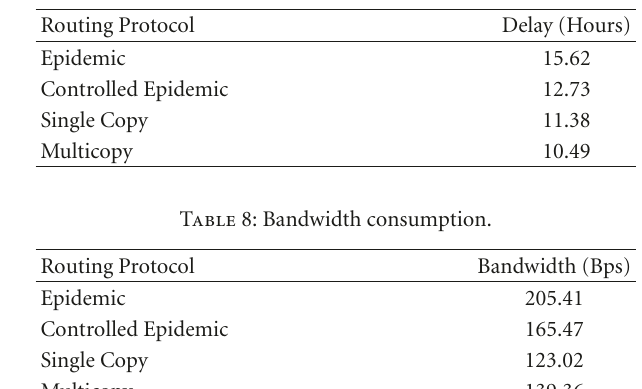
Table 6: Delivery rates. Table 7: Delivery delay.